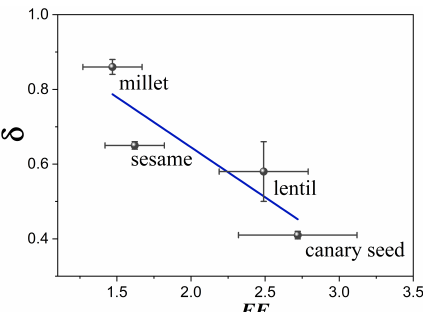
Figure 3. Shape arc parameter δ (obtained from the measure- ments in a flat-bottom configuration) as a function of the form factor FF of the seeds.